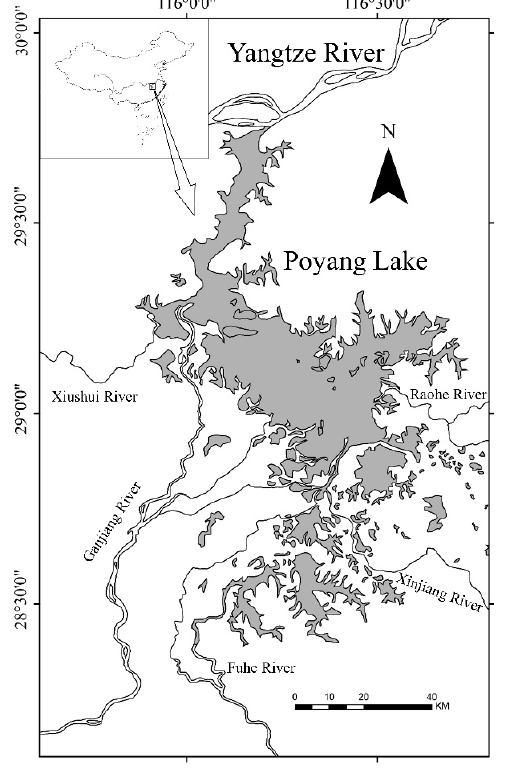
Figure 1. The map of the Poyang Lake basin and its upstream tributaries. The shaded area shows the area of the Poyang Lake.